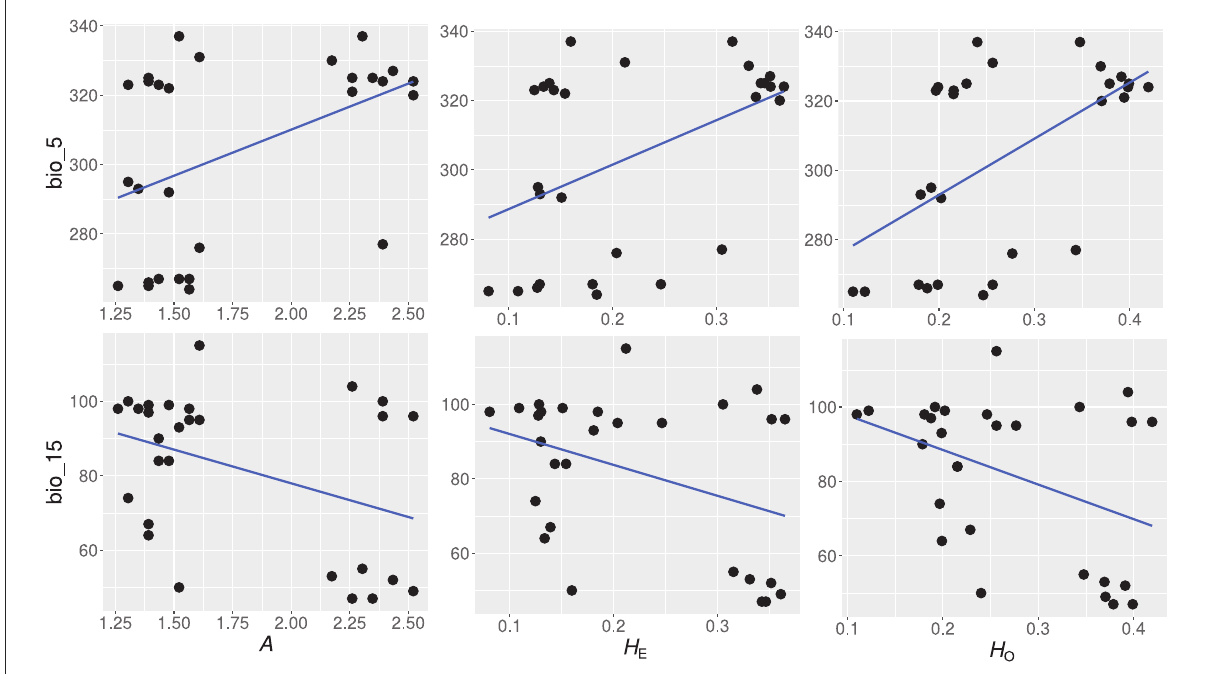
FIGURE5 Significant relationships between genetic diversity estimators and the two most important environmental variables, based on variance inflation factor (VIF) analysis. A , number of alleles per population; H E , expected heterozygosity; H O , observed heterozygosity; bio_5; Maximum temperature of the warmest month, bio_15; precipitation